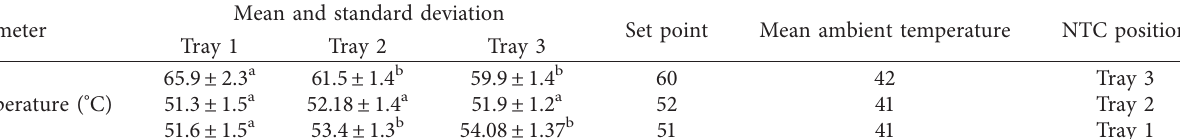
Table 2: Temperature reading on the trays in licking mode for different NTC positions.